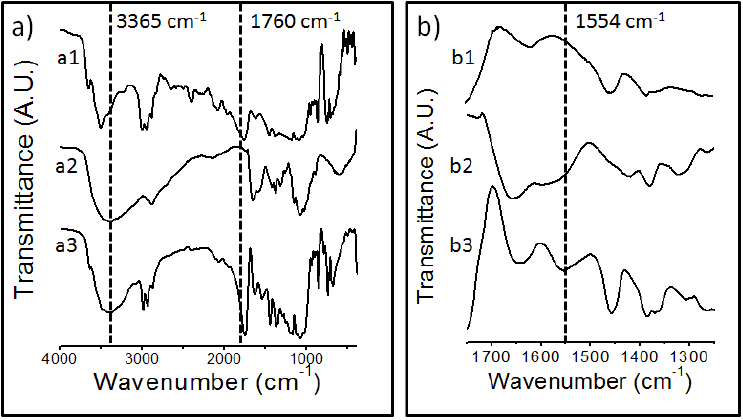
Figure 1. FTIR spectra of ( a ) full spectrum, ( b ) range of 1750–1250 cm − 1 : (1) chitosan, (2) PLA, (3)